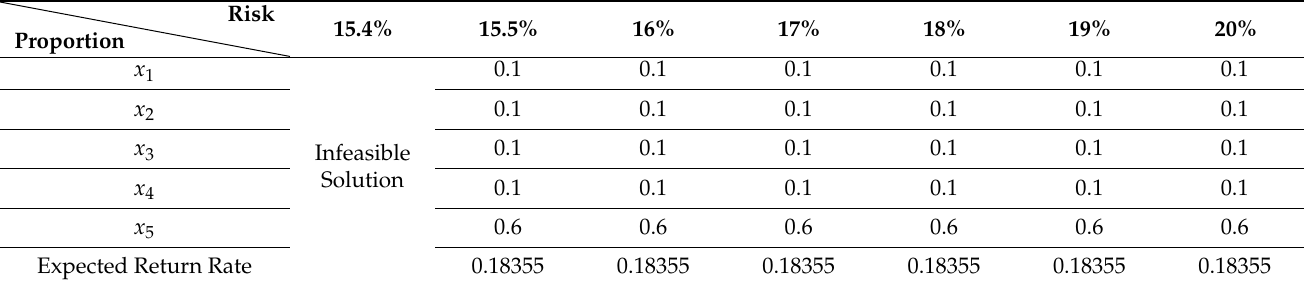
Table 6. The efficient portfolio with s = 1 in a guaranteed return rate (cid:101) p 3